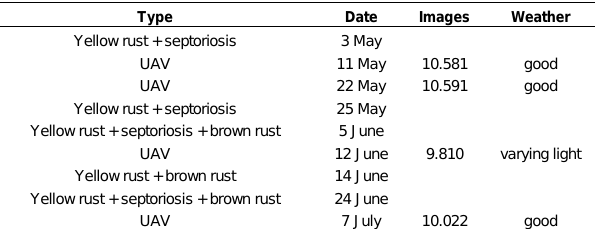
Table 1. Details of COSI flight campaigns and disease observations for the wheat monitoring study.